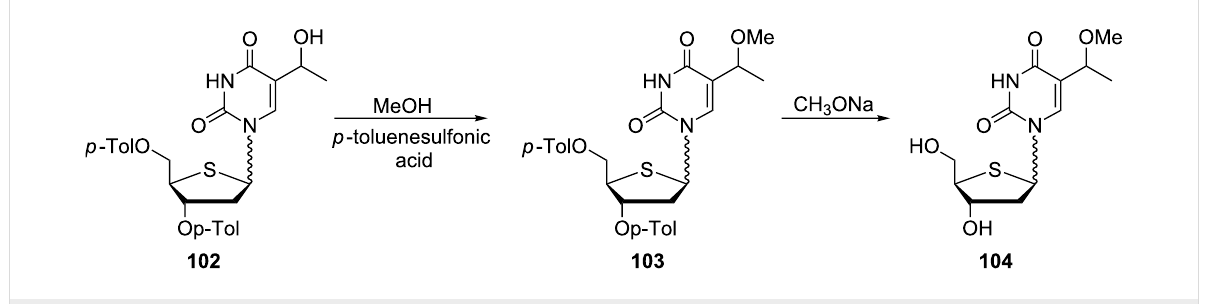
Scheme 17: Synthesis of 2'-deoxy-5-(1-methoxyethyl)-4'-thiouridine ( 104